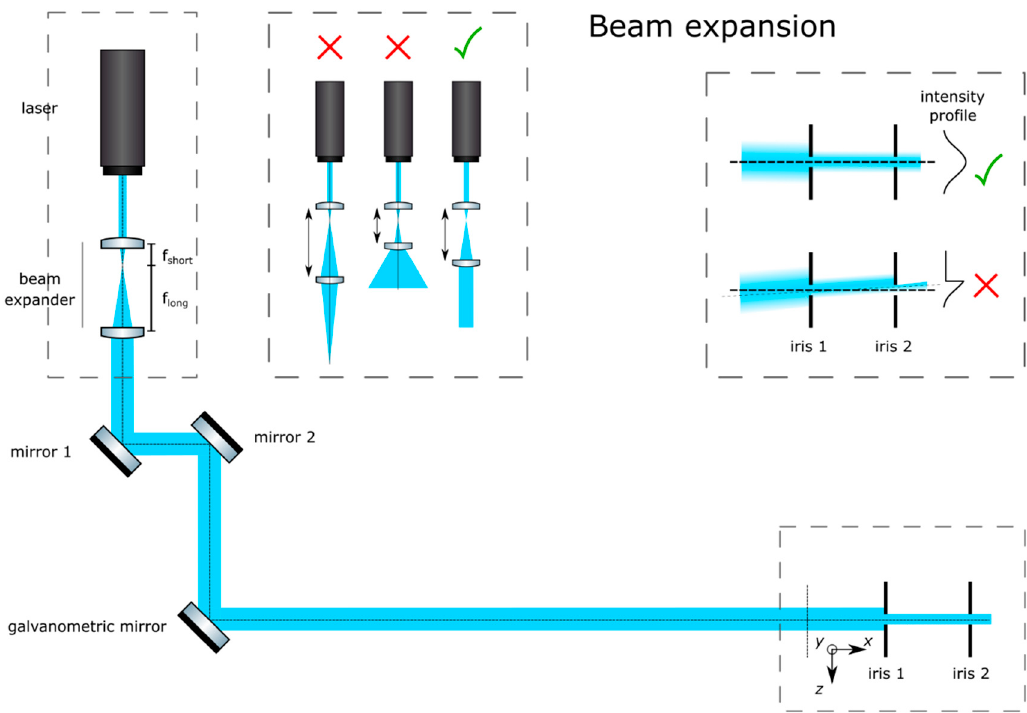
Figure 3. Beam expansion. Adjust the distance between the two lenses to guarantee that a collimated beam is achieved. Adjust their lateral positions so that the beam is not deviated.